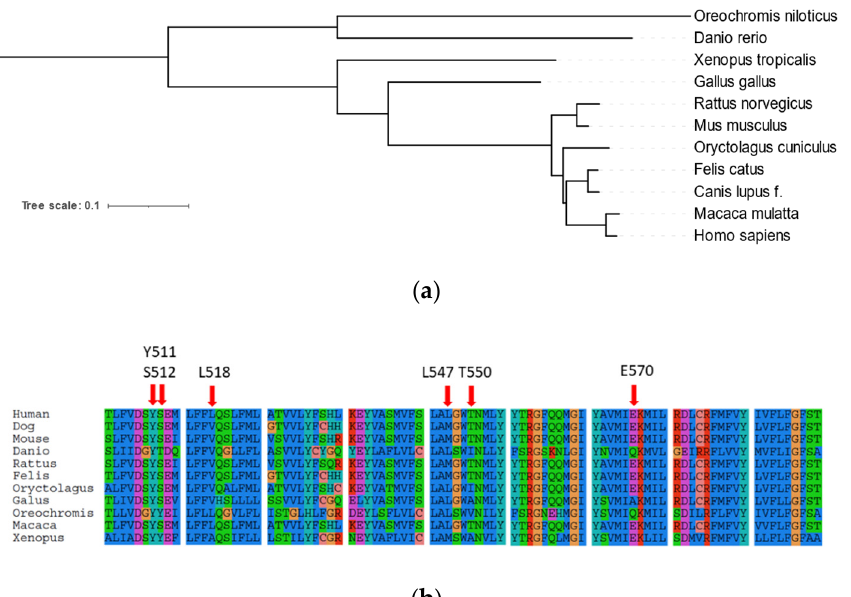
Figure 2. Analysis of TRPV1 orthologs. ( a ) Phylogenetic tree of TRPV1 orthologs. TRPV1 of Carnivora is more closely related to primates than to rodents. The tree was constructed using available TRPV1 sequences and the FastMe algorithm. The tree was visualized using Interactive Tree of Life. Scale Bar indicates branch length. ( b ) Comparison of TRPV1 orthologs amino acid positions known from the literature to be involved in capsaicin sensitivity. Canine TRPV1 sequence shares similarity to human, mouse, rat, and cat in terms of capsaicin-sensitive aa positions. Substitutions at these positions are associated with the channel that is less responsive or not responsive to CAP as in the case of rabbit, chicken, frog, and fish.